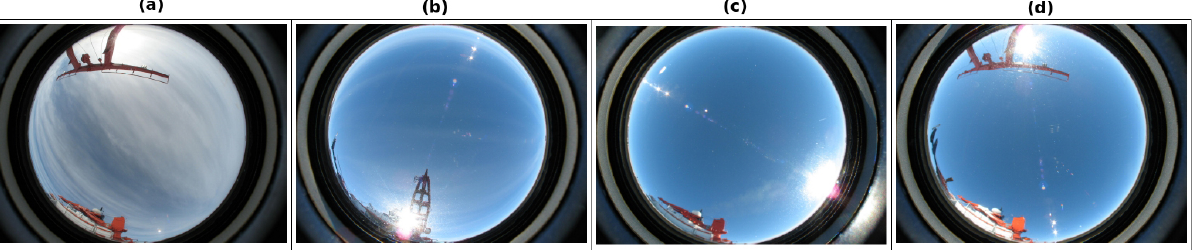
Figure A1. Sky-camera photographs for 2 July 2017 04:00:08Z (a) , 2 July 2017 12:13:33Z (b) , 3 July 2017 04:14:09Z (c) , and 3 July 2017 12:04:08Z (d) . All times in UTC.